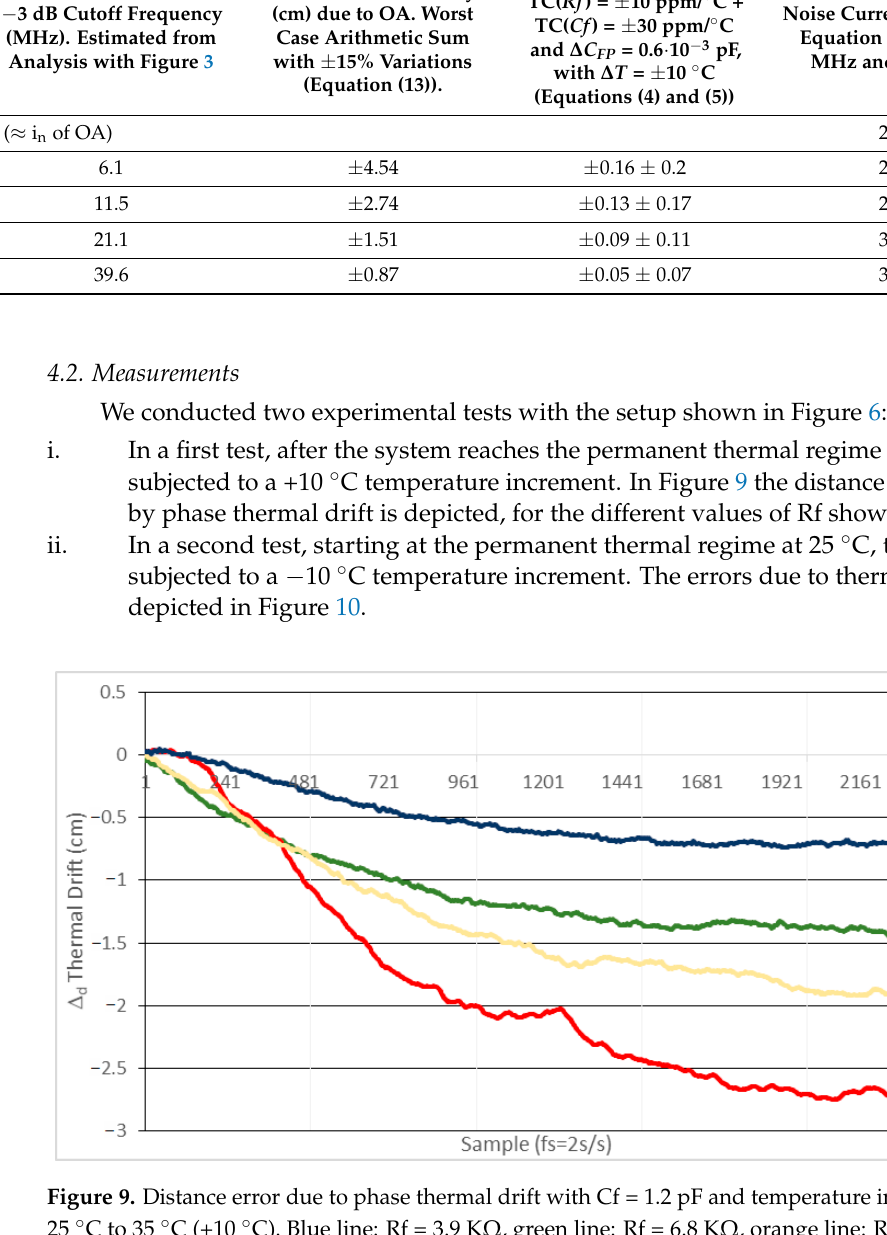
Figure 10. Distance error due to phase thermal drift with Cf = 1.2 pF and temperature increment from 25 ° C to 15 ° C ( − 10 ° C). Blue line: Rf = 3.9 K Ω , green line: Rf = 6.8 K Ω , orange line: Rf = 12 K Ω and red line: Rf = 22 K Ω .